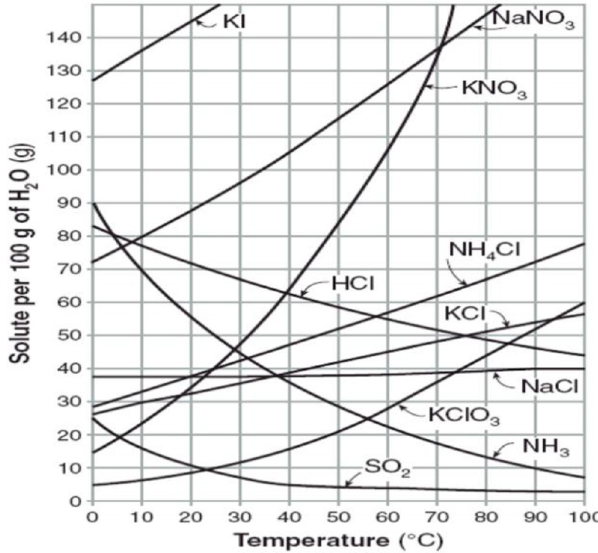
Fig. 4. Solubility curves (Aizaz and Yousaf,